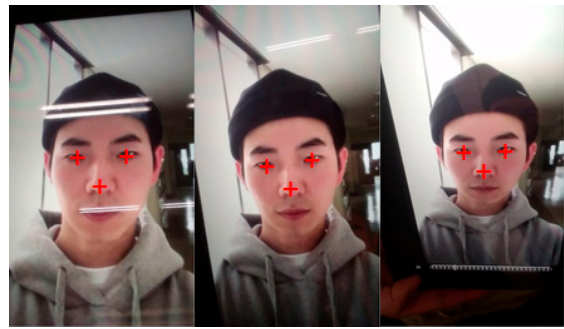
Figure 8. Results for MTCNN using fake face data from a replay video attack.